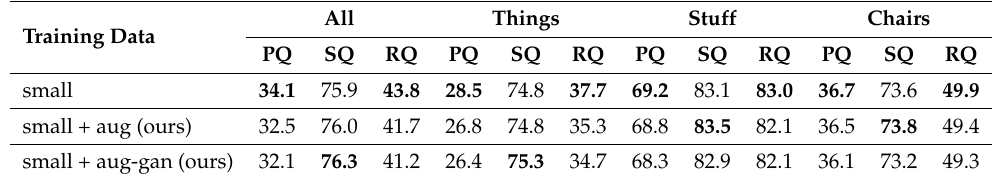
Table 6. Neural network results for panoptic segmentation on NYUv2 dataset and its augmentations. Numbers in bold indicate the best result in the